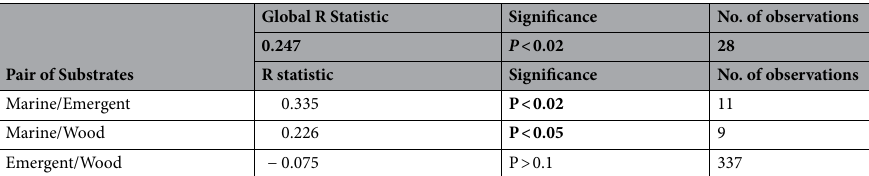
Table 1. Global R statistic and pairwise comparisons of fungal community similarities between different substrates based on T-RF species relative abundance data. R statistics and p -values from ANOSIM. Bold font shows statistically significant